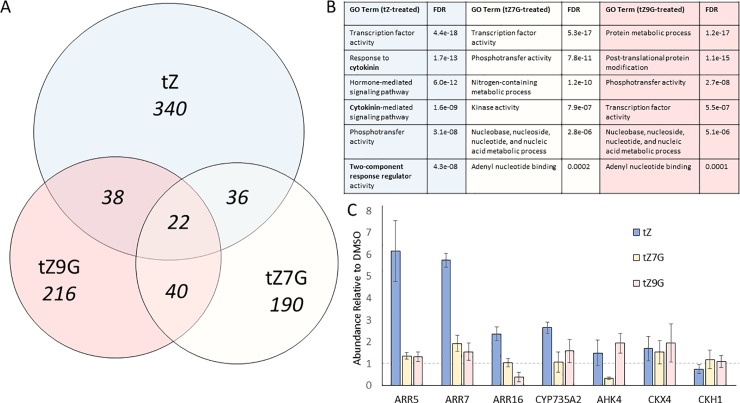
trans-Zeatin-N-glucosides alter the Arabidopsis transcriptome distinctly from trans-Zeatin.A, Venn diagram showing number of differentially expressed transcripts after two-hour treatment of 10dag WT Arabidopsis seedlings with 1μM hormone. B, tZ-treated seedlings are enriched for CK-related Gene Ontology terms, unlike tZ7G- and tZ9G-treated seedlings. C, qRT-PCR confirmation of RNAseq results; data presented is average ± SE of three independent biological replicates. Treatment with tZ7G or tZ9G does not mimic treatment with tZ with regards to regulation of most tested CK-related genes.